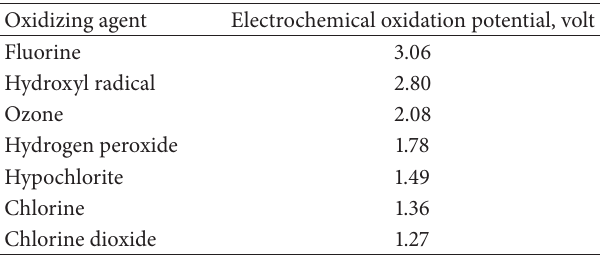
Table 1: Oxidizing potential for conventional oxidizing agents